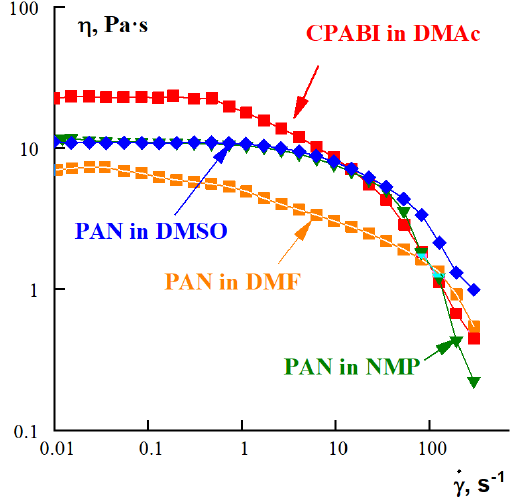
Figure 4. Viscous properties (non-Newtonian flow curves) of CPABI and PAN solutions in different solvents (shown at the curves).